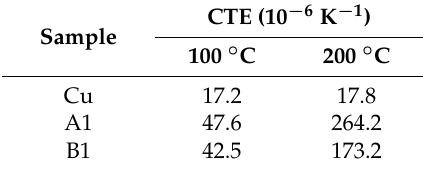
Figure 9. Temperature dependences of the ( a ) dimensional changes and ( b ) CTE of the B1 sample (FR4 laminate/Cu plated holes) observed after two runs. Table 1. CTE values obtained for the Cu, A1, and B1 samples after 2